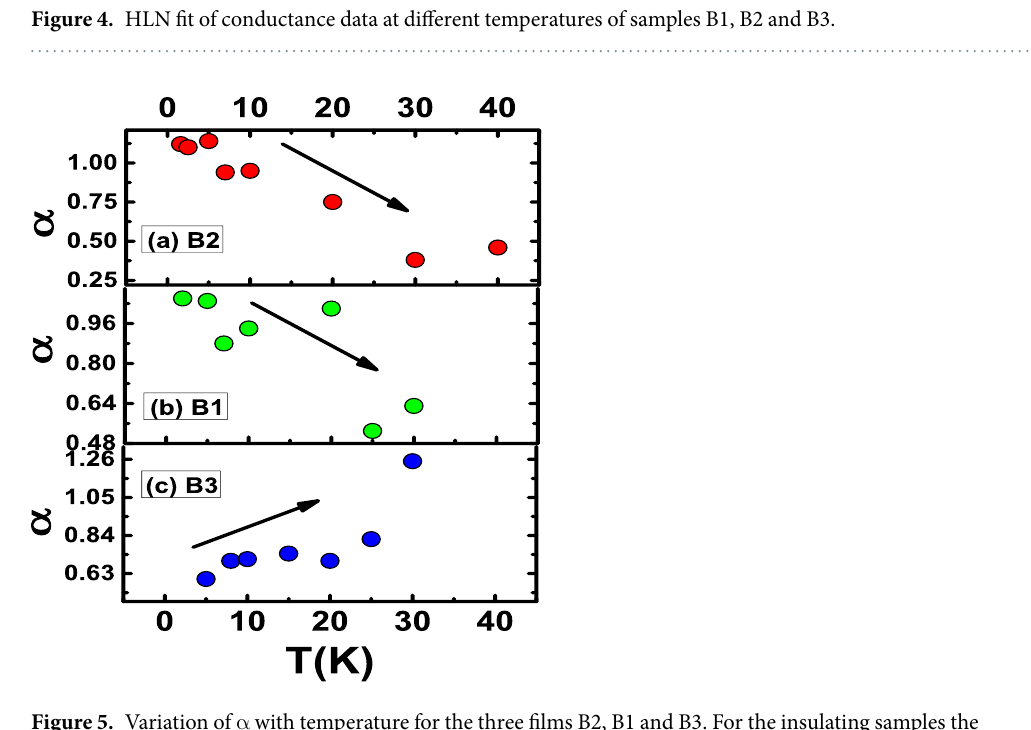
Figure 5. Variation of α with temperature for the three films B2, B1 and B3. For the insulating samples the behavior of α is opposite to that for the metallic film B3. The direction of the arrow signifies increasing or decreasing trend of α for metallic or insulating